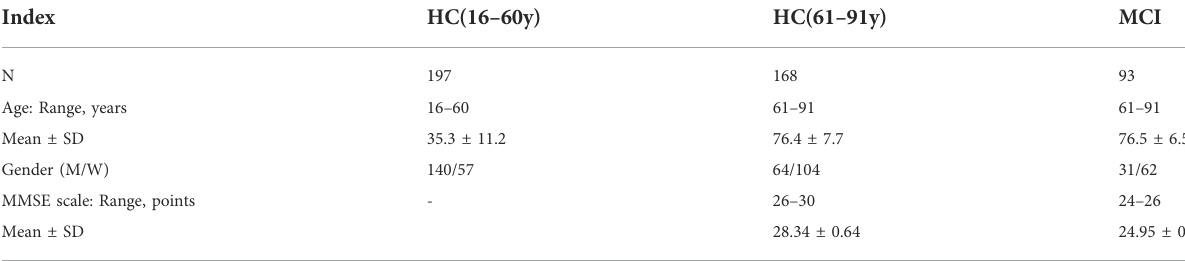
TABLE 1 Demographic and clinical measures in the MCI patients and HC